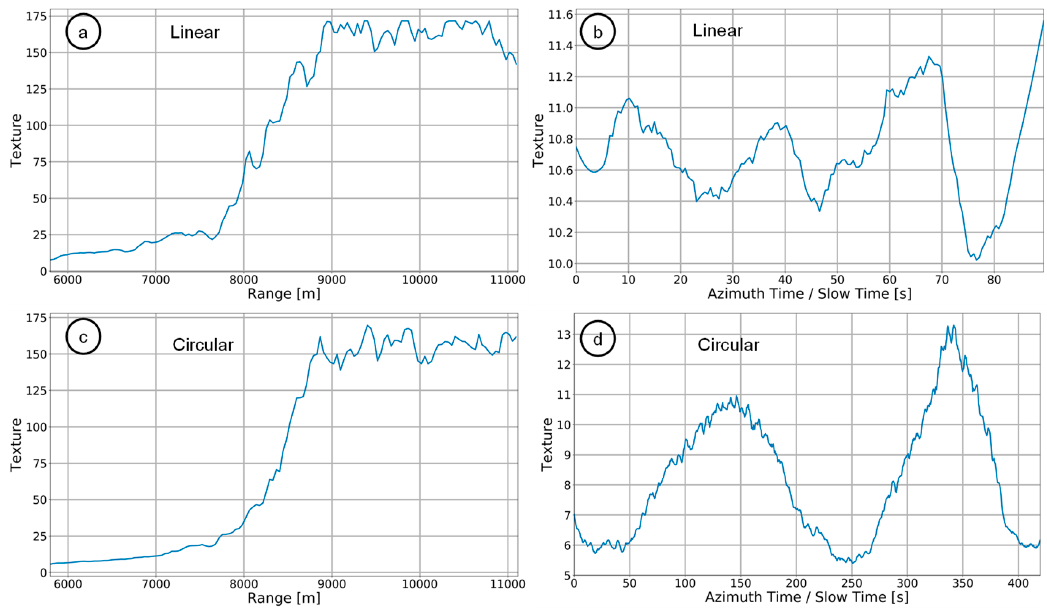
Figure 17. Estimated texture parameter of the K-distribution along ( a , c ) range and ( b , d ) azimuth using data acquired during a linear and circular flight.